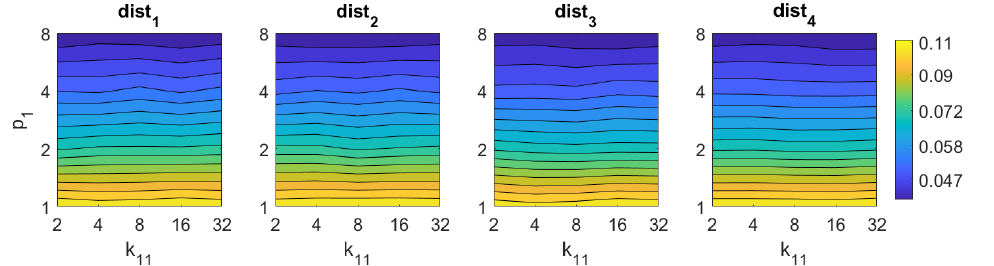
Figure 17. BF image retrieval problem. Computational time.